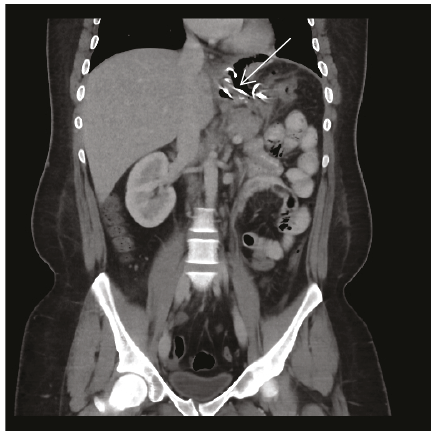
Figure 4: Abdominal computed tomographic scan with intravenous contrast shows no leakage, and as compared to the previous study, the collection regressed after putting a stent. Arrow: displaced stent into the